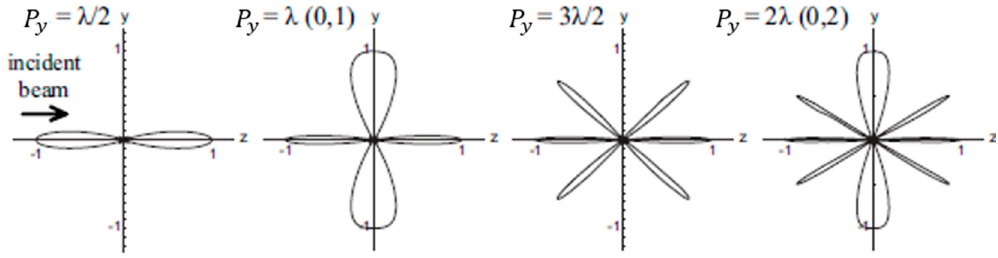
Figure 2. Scattering along periodic interfaces. Far-field intensity distribution of scattered light calculated for 1D arrays with di ff erent periodicities P y located in the xy -plane and illuminated along z . Adapted with permission from ref [38], The Optical Society.